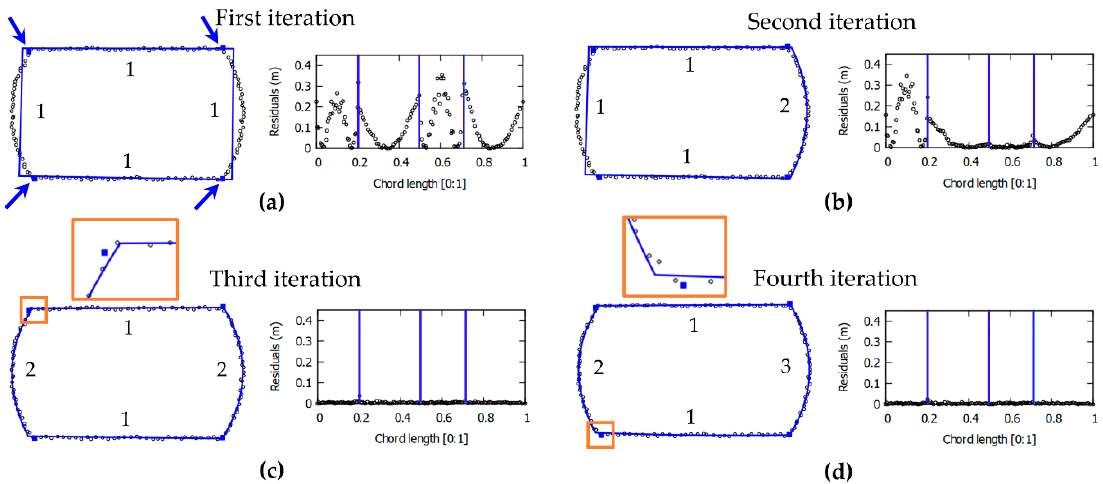
Figure 5. Illustration of the regularization process using the iterative approach of CD-spline. Results obtained in the first ( a ), second ( b ), third ( c ) and fourth ( d ) iteration. Black points represent the boundary points, whereas blue square and blue contours correspond to the critical points and the regularized boundary, respectively. The adjacent number to each modeled segment corresponds to the degree of the polynomial used to model this segment. The graphics illustrating the magnitude of residuals for each boundary point with each segment delimited by the vertical blue lines are also shown to the right of the modeled boundary through the different iterations.3.3. Quality Parameters.